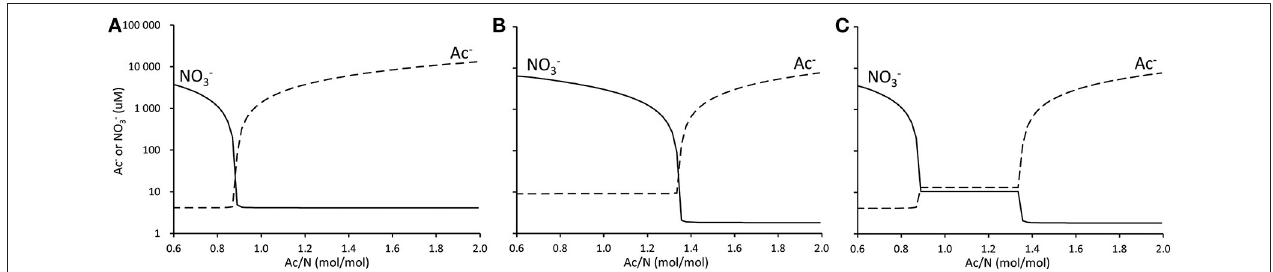
FIGURE 5 | Calculated change in residual nitrate (solid line) and acetate (dotted line) concentrations for change of influent Ac/N ratio in a chemostat enrichment culture. (A) , Denitrification only. (B) , DNRA only. (C) , Denitrification and DNRA.